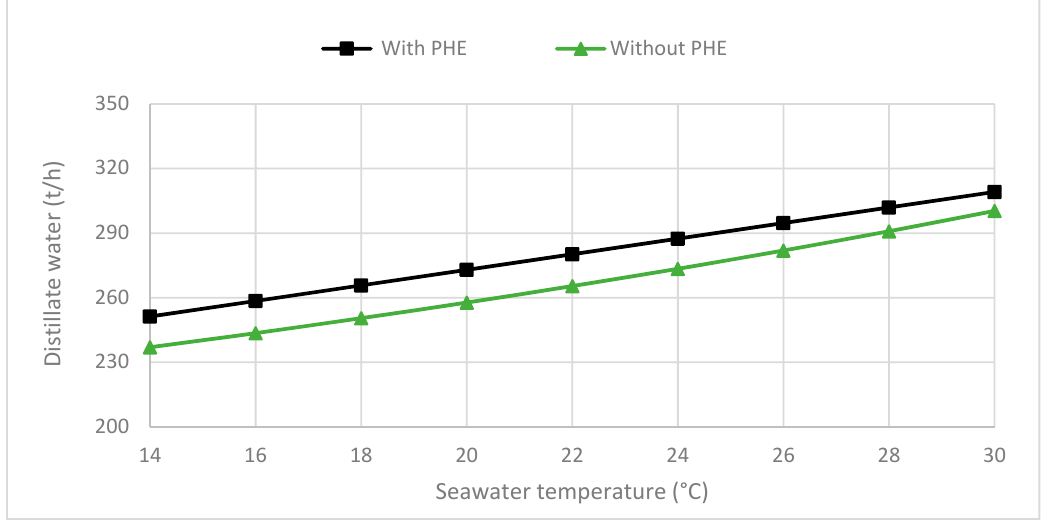
Figure 3. Distillate water production in tonne per hour for both systems versus seawater temperature.